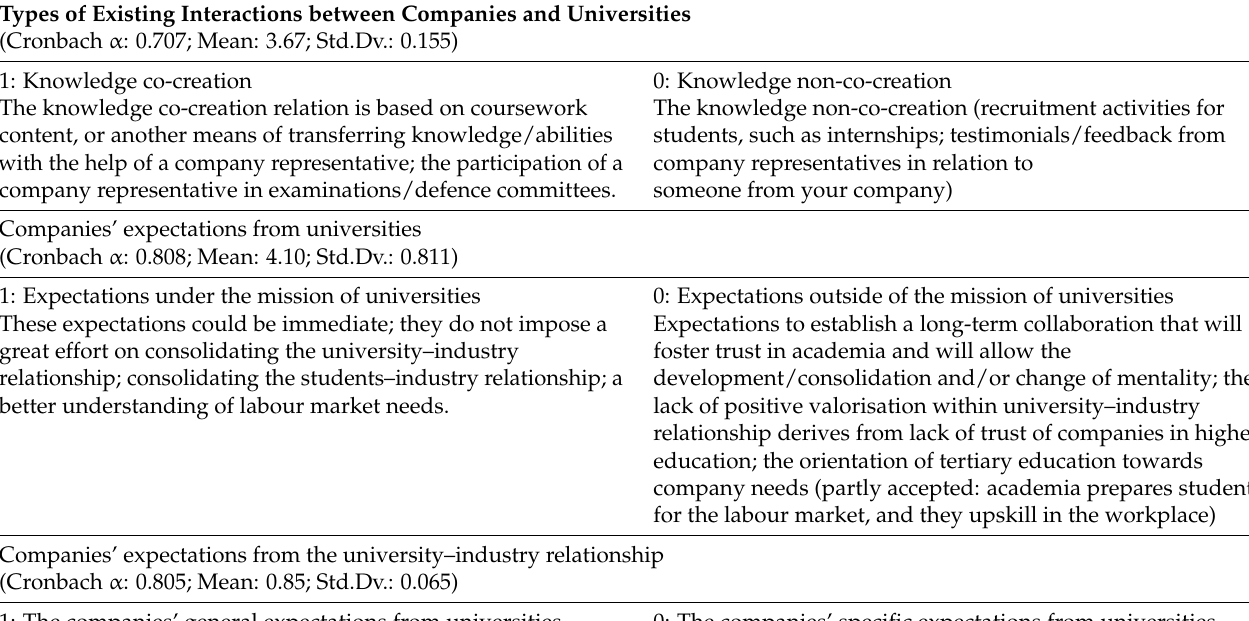
Table A1. Input variables used in the QCA